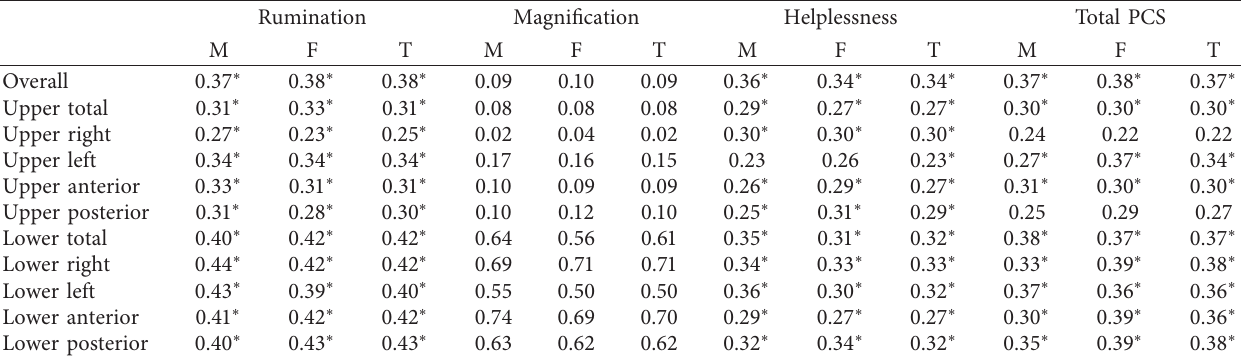
Table 6: Correlations of component and total scores of PCS with VAS scores. Rumination Helplessness